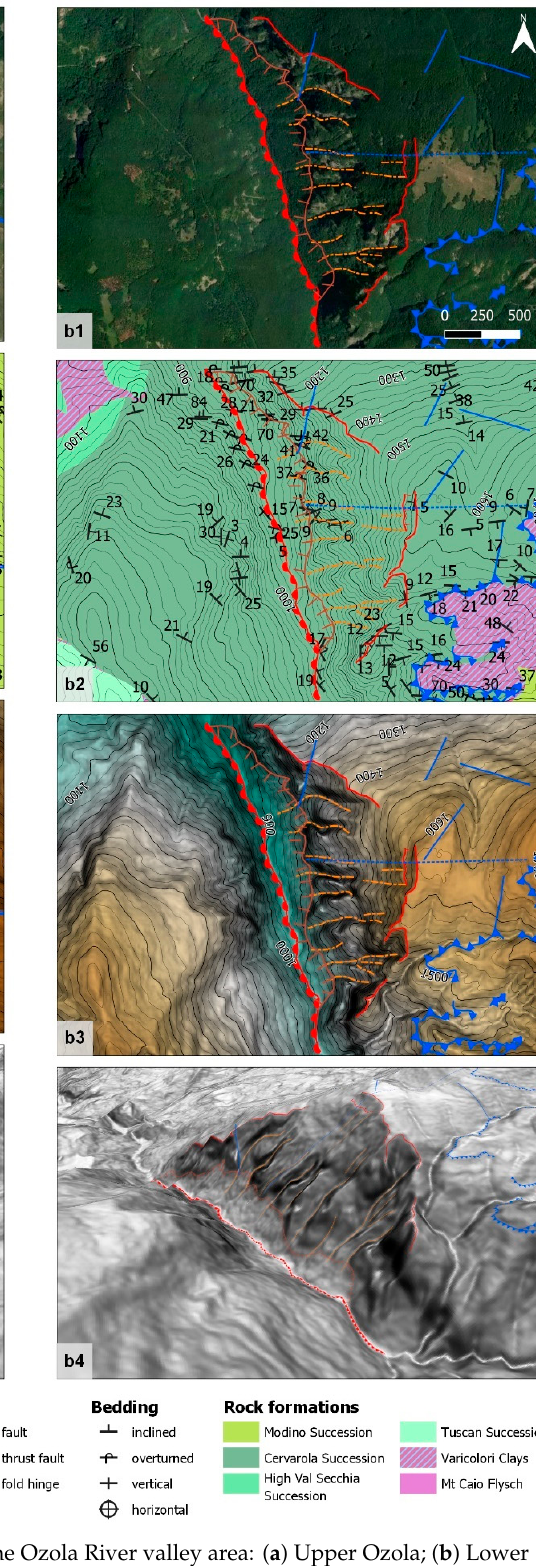
Figure 4. Detailed mapping of the DSGSDs in the Ozola River valley area: ( a ) Upper Ozola; ( b ) Lower Ozola. For both landforms the main surface geomorphological features are represented on: ( 1 ) Google Earth™ satellite image (Google 2020, seen on 30 July 2020); ( 2 ) geological map at scale 1:50,000 [87]; ( 3 ) colorized DTM-slope layer mesh; ( 4 ) DTM-derived 3D model.